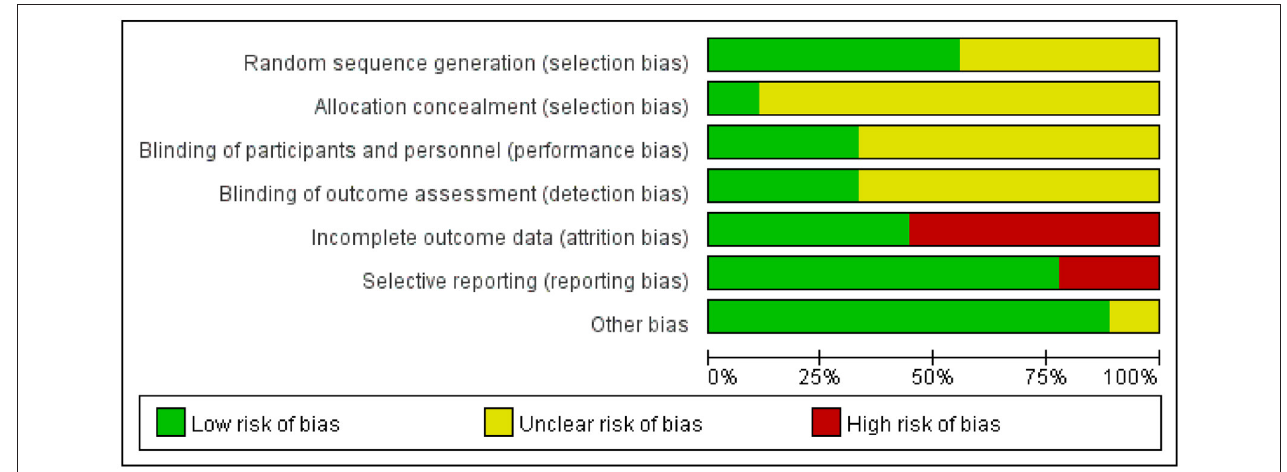
FIGURE 2 | Risk of bias graph: review authors’ judgements about each risk of bias item presented as percentages across all included